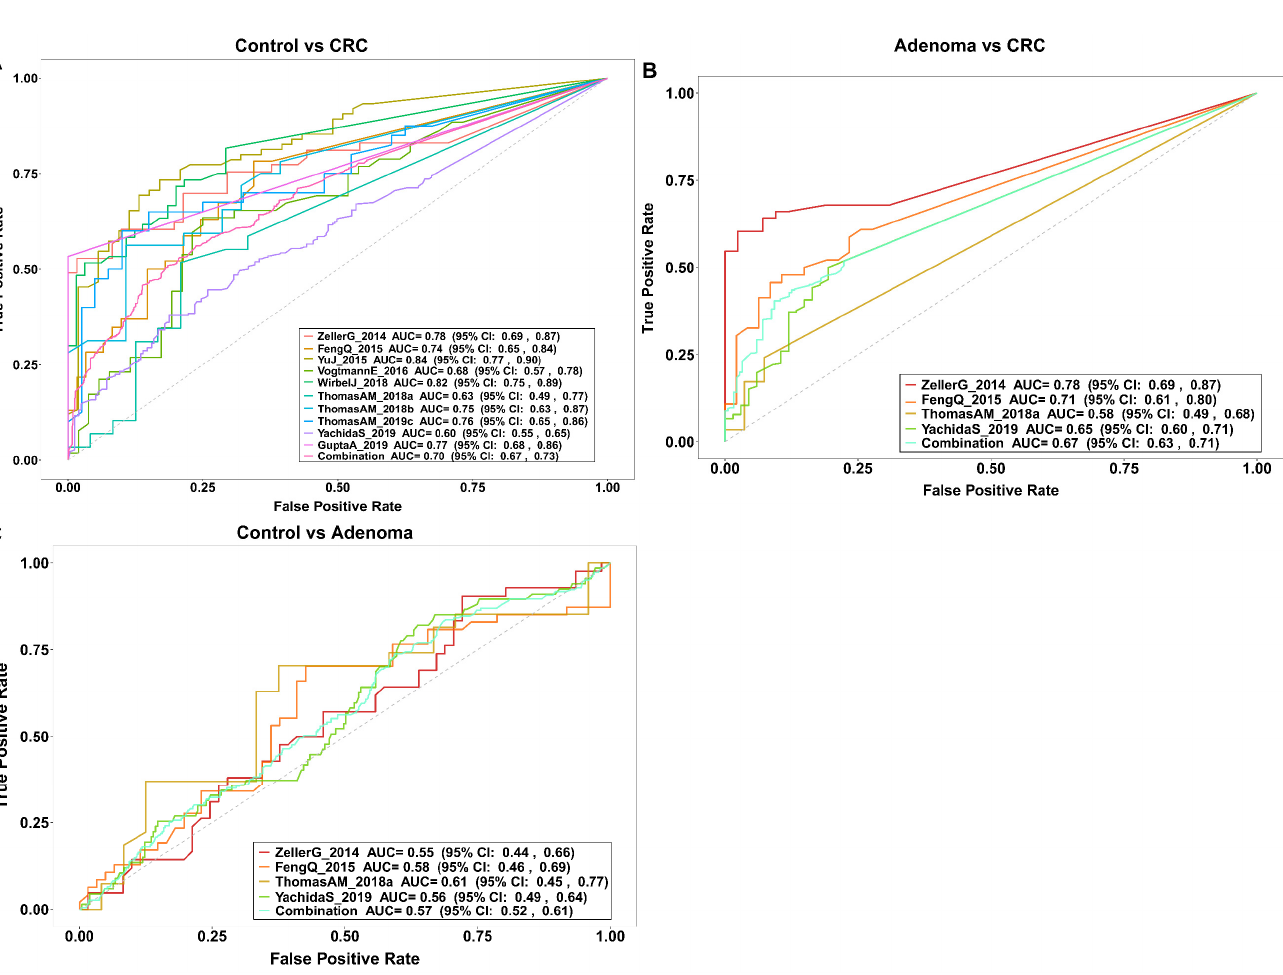
Figure 3. The prediction powers of bacterial classifiers in external validation datasets. ( A ) The prediction performance of the bacterial classifier for the classification of CRC and control status in 10 validation datasets shown by the area under the curve (AUC) of receiver operating characteristic (ROC). ( B ) The ROC curve of the classifier for classification of CRC and CRA status in four validation datasets. ( C ) The ROC curve of the classifier for classification of CRA and control in four validation datasets.